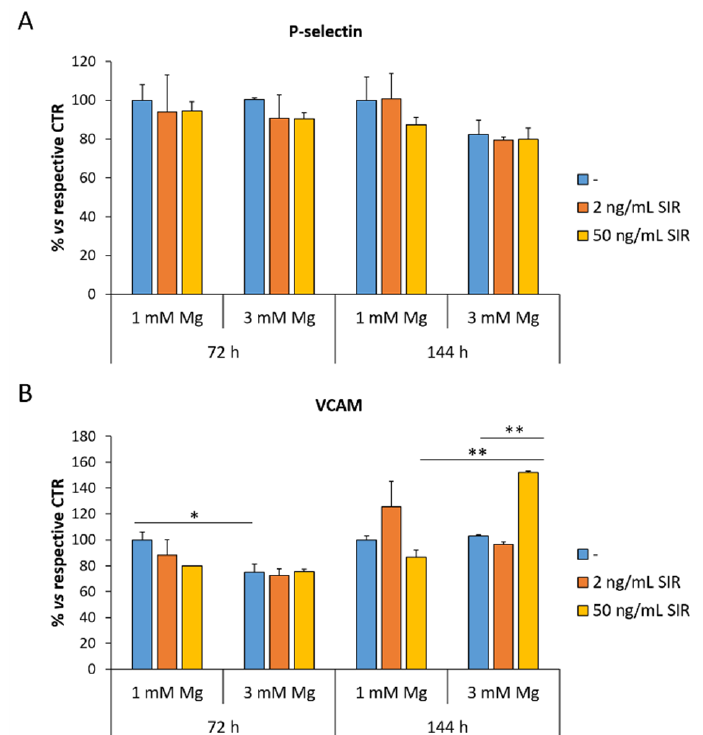
Figure 2. The effects of sirolimus and Mg on the total amounts of P-selectin and VCAM. ELISA was performed on cell extracts after 72 and 144 h of culture in medium containing 1 or 3 mM Mg in the presence of 2 or 50 ng/mL of sirolimus. ( A ) P-selectin ( B ) VCAM. Data are expressed as the mean ± standard deviation of three independent assays (* p ≤ 0.05; ** p ≤ 0.01).